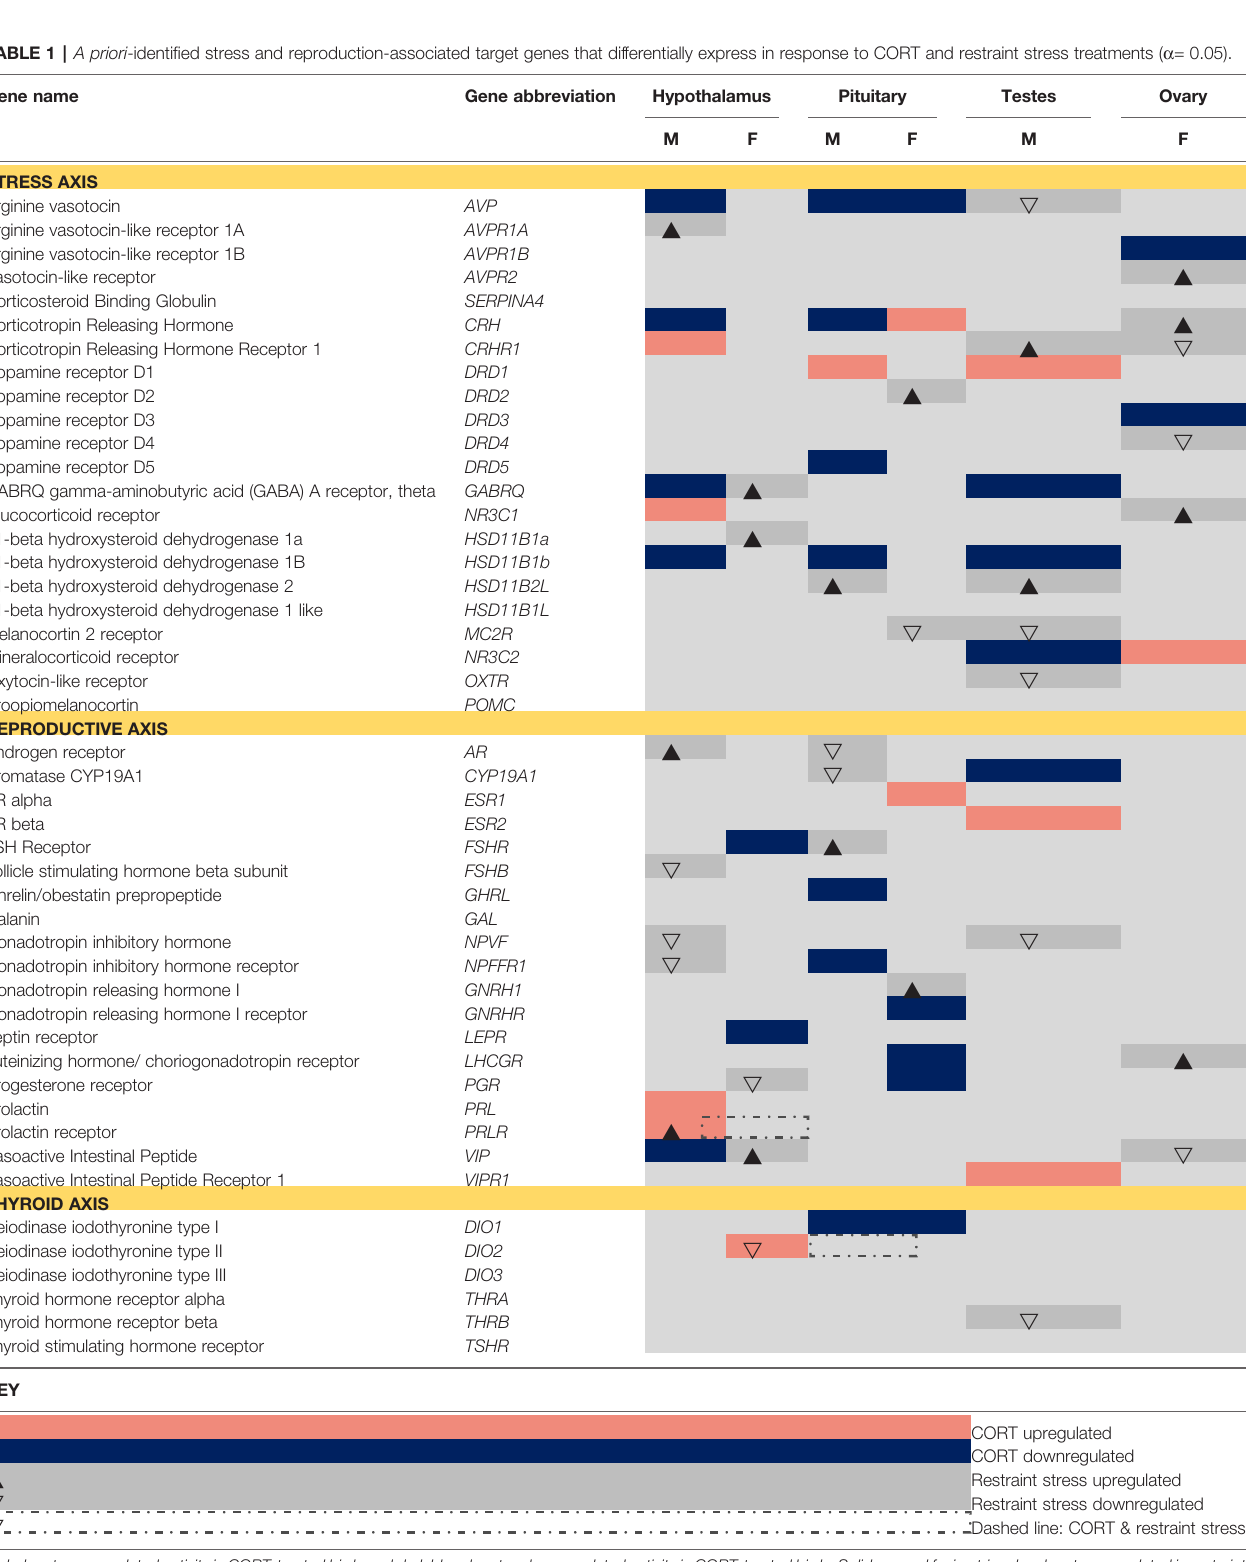
▽ Restraint stress downregulated ▽ Dashed line: CORT & restraint stress PinkdenotesupregulatedactivityinCORT-treatedbirdsanddarkbluedenotesdownregulatedactivityinCORT-treatedbirds.Solidupwardfacingtrianglesdenoteupregulatedinrestraint stress birds, and open downward facing triangles denote downregulated in restraint stress birds. Dashed lines denote a signi fi cant change in gene expression in both restraint stress and CORT-treated